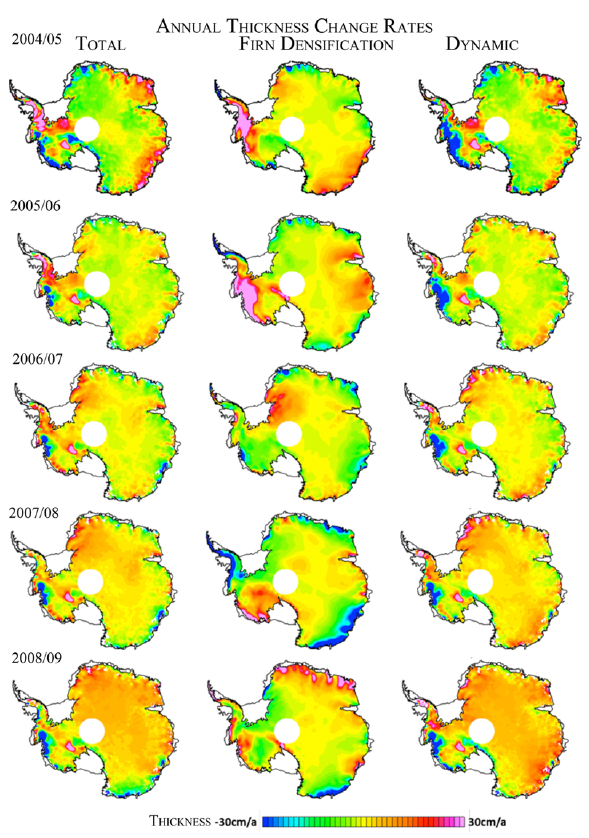
Figure 3. Annual total, surficial process (SMB and firn- compaction) and ice dynamic related thickness change rates,